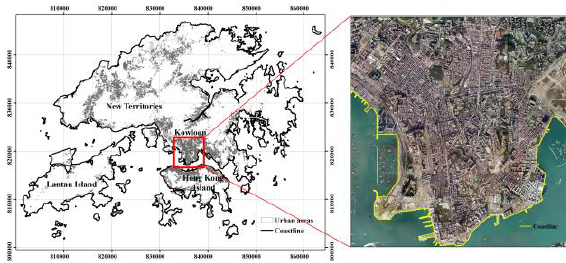
Figure 1. The study area: Kowloon Peninsula in Hong Kong (The right: DOM in 2014)